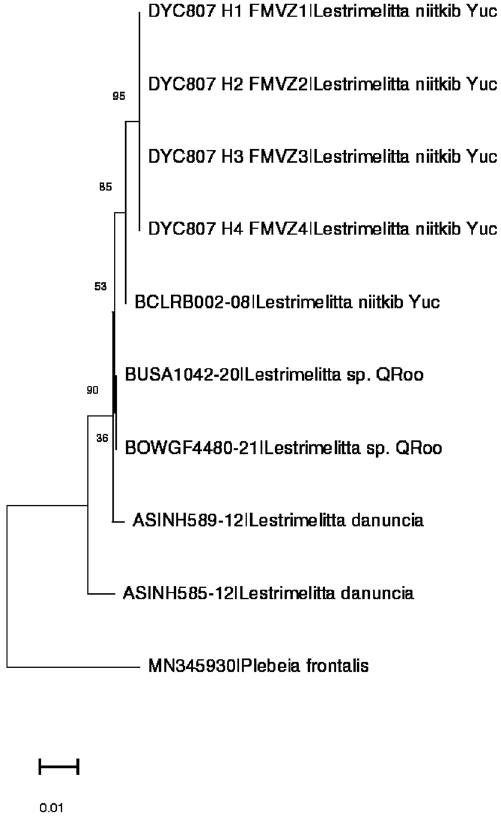
Figure 6. NJ tree obtained from the analysis of the fragment Cox 1 of the mt DNA of Lestrimelitta specimens from the Yucatán Peninsula ( Yuc Yucatan State; QRoo Quintana Roo State) and from Costa Rica ( Lestrimelitta danuncia ), with Plebeia frontalis as outgroup. Values show bootstrap branch support (500 replicates). The bar represents nucleotide sequence divergence.